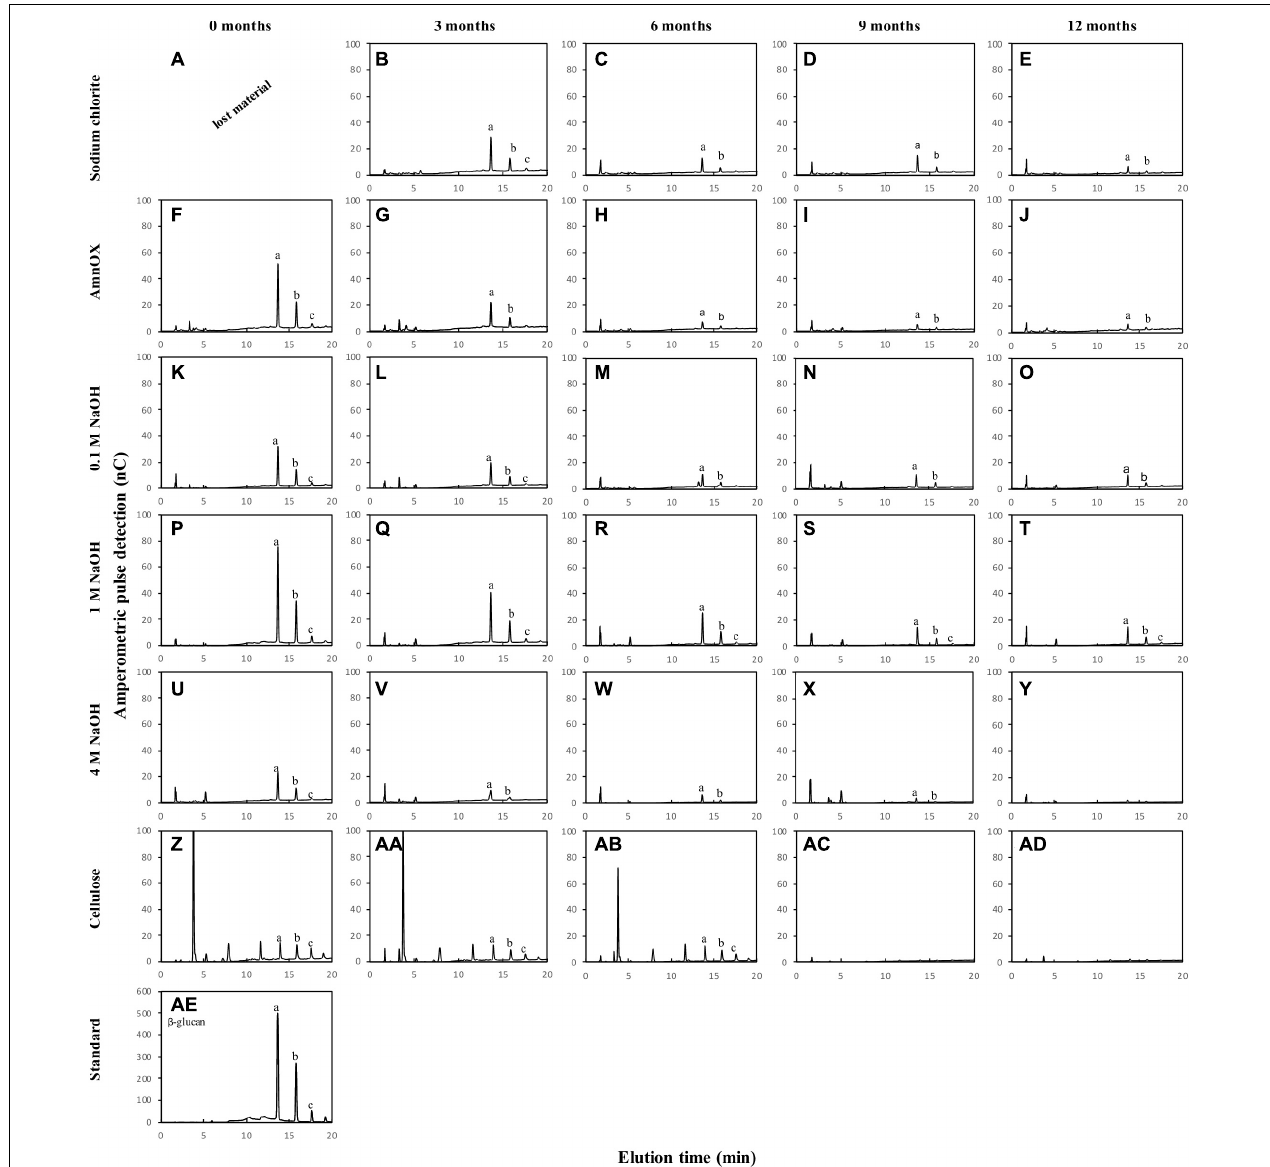
FIGURE 4 | Oligosaccharide profile of cell wall fractions from sugarcane straw under field conditions for 12 months. The cell wall fraction was treated with a specific enzyme that cleave β -glucan - lichenase (Megazyme; n = 5). The cell wall fractions are represented on the y-axis and the straw field time in months on the x -axis. The β -glucan is determined by the peaks at the retention times of 13 and 16 min (AE) , therefore this pattern should be adopted for the evaluation of polysaccharide degradation on the fraction’s sodium chloride (A–E) , ammonium oxalate (F–J) , 0.1 M NaOH (K–O) , 1 M NaOH (P–T) , 4 M NaOH (U–Y) , and cellulose (Z–AD) . The lowercase letters inside the chromatogram represent (a) β -glucan trisaccharide, (b) β -glucan tetrasaccharide, and (c) β -glucan pentasaccharide. The data from (A) was lost during the sample processing ( n =